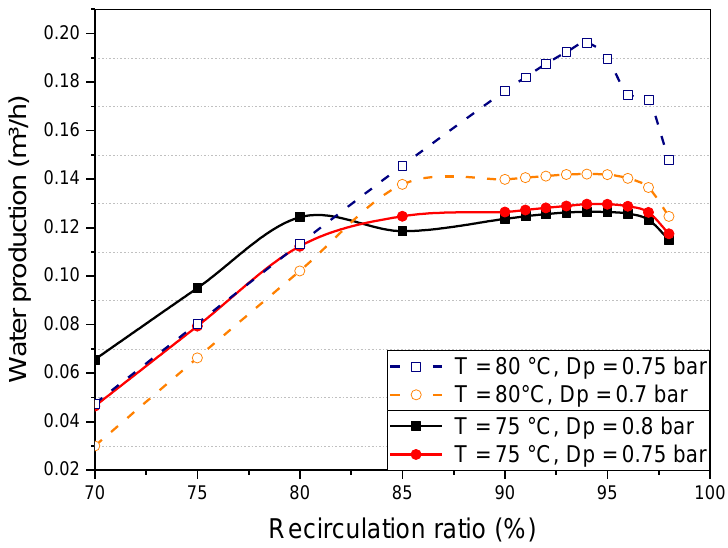
Figure 10. Water production as the recirculation ratio increases for two set-points at pressure differ- ences, Δ p = 0.7, 0.75 and 0.8 bar.